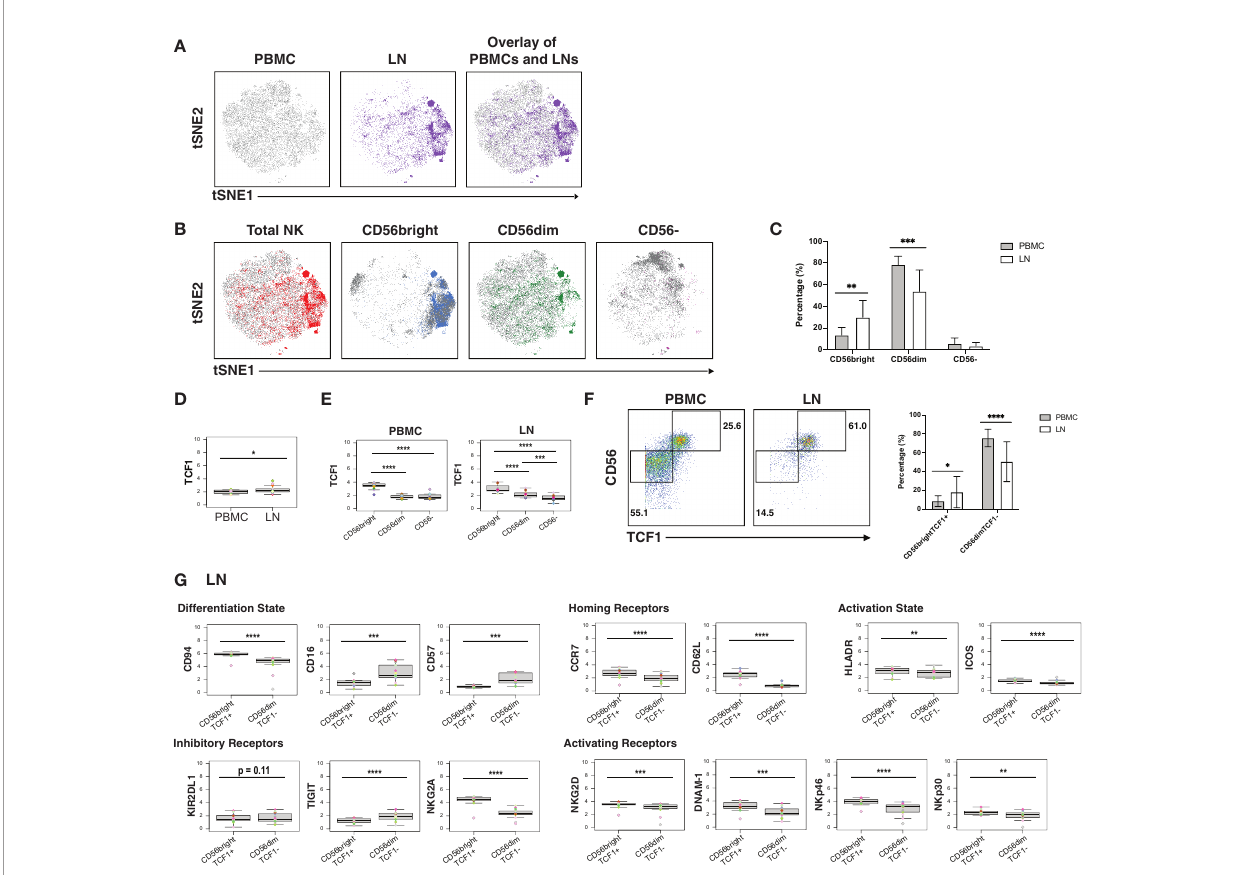
FIGURE 5 | CD56 bright NK cells from PLWH display phenotypic features of memory and are enriched in LNs. (A) tSNE plots demonstrating the overall differences between total NK cells from blood (grey) and LN (colored). (B) NK cell subsets, de fi ned by CD56 expression (total, CD56 bright , CD56 dim , CD56-), are phenotypically distinct in blood (grey) as compared to LNs (colored). (C) NK cells from PBMCs have increased frequencies of CD56 dim cells, while NK cells from LNs have increased frequencies of CD56 bright cells. Shown are the percentages of the indicated populations among total NK cells. (D) TCF1 expression is higher in NK cells from LNs than from blood. MSI of TCF1 in total NK cells from PBMCs and LNs are shown. Expression levels of other antigens on these two cell populations are presented in Figure S8 . (E) TCF1 expression is highest in the CD56 bright subset of NK cells. MSI of TCF1 in NK cell subsets from PBMCs and LNs are shown. (F) LNs harbor a larger proportion of CD56 bright TCF1+ NK cells than do PBMCs. Representative gates (left) and frequencies (right) of CD56 bright TCF1+ and CD56 dim TCF1- NK cells in PBMCs and LNs. (G) LN CD56 bright TCF1+ NK cells are less differentiated and express increased levels of LN homing receptors, activation markers, and activating NK receptors than LN CD56 dim TCF1- NK cells. Shown are MSI levels of the indicated markers assessed in CD56 bright TCF1+ and CD56 dim TCF1- NK cells from LNs. Plots comparing MSI of the indicated markers between CD56 bright TCF1+ and CD56 dim TCF1- NK cells from PBMCs are presented in Figure S8 . *p<0.05, **p<0.01, ***p<0.001, ****p<0.0001 as assessed using the Student ’ s paired t test and for MSIs, adjusted for multiple testing using the Benjamini-Hochberg for